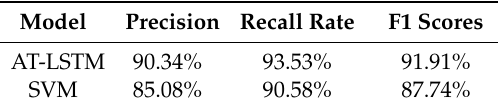
Figure 14. Confusion matrix for model identification 0.6 s in advance. ( a ) AT-LSTM model. ( b ) SVM model.